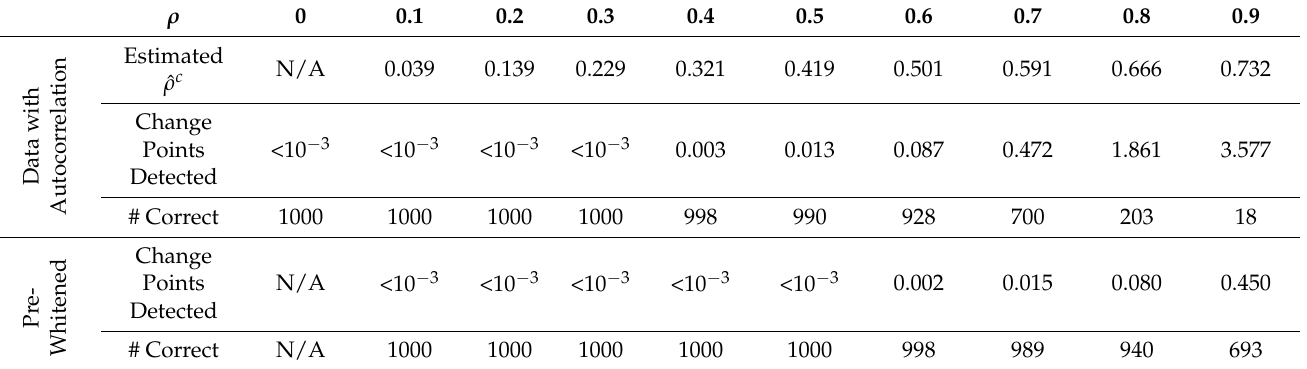
Table A1. Autocorrelation in a Linear Trend Model. A total of 1000 datasets were generated for each value of the autocorrelation parameter, ρ , for a model that includes a linear trend. The average number of change points detected by the Bayesian change point model before and after pre-whitening is indicated for each value of ρ , along with the number of datasets (out of 1000) where the algorithm correctly identified zero change points (i.e., the number of datasets where the expected number of change points <0.5). Note that a value of ρ = 0 corresponds to white noise.